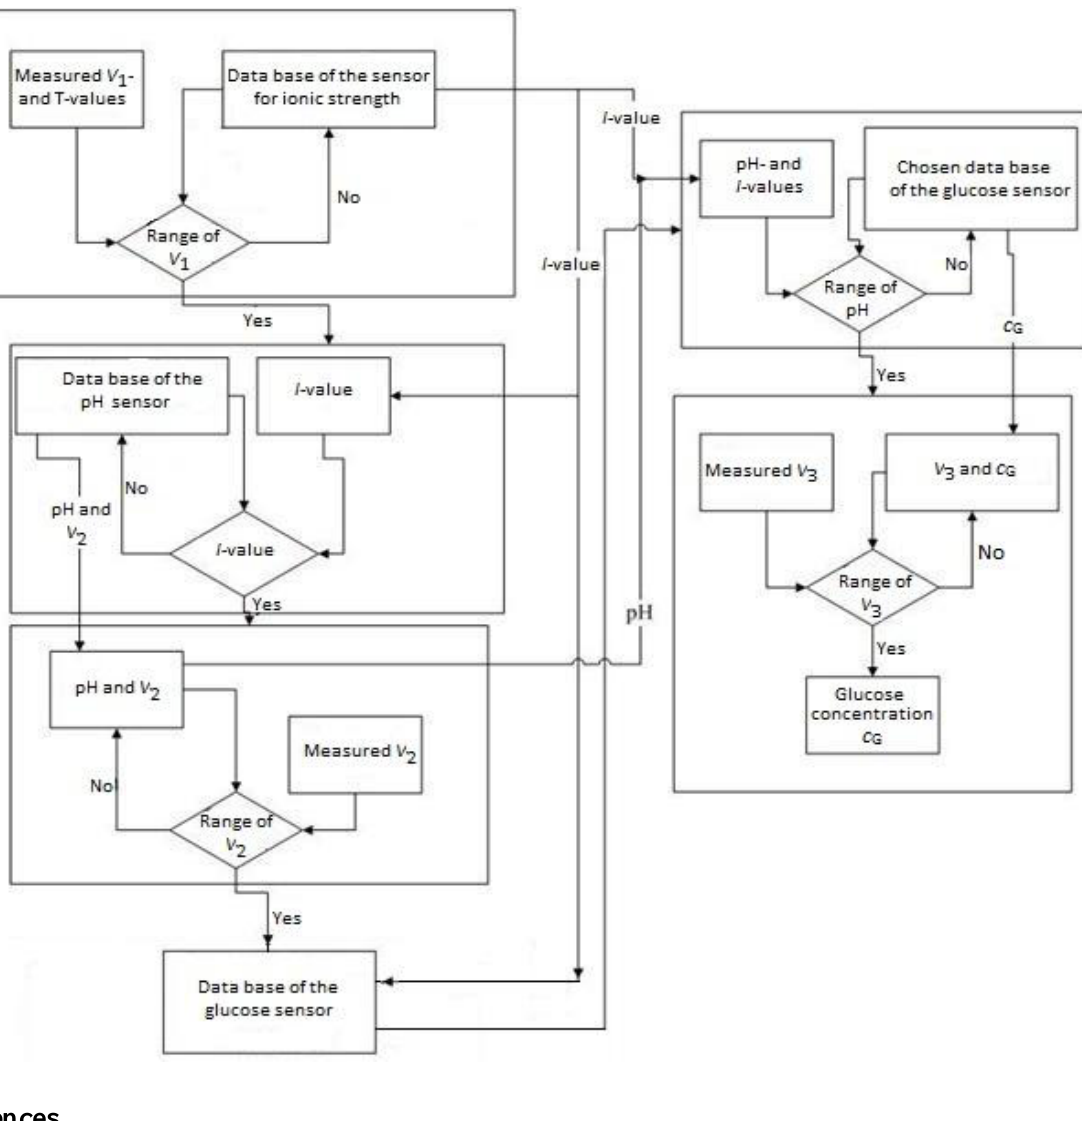
Figure E1. Flowchart of the programme for the calculation of the corrected values of pH and glucose